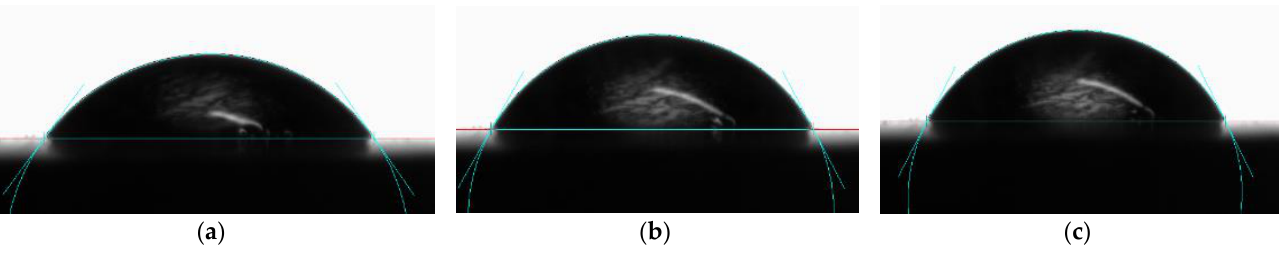
Coatings 2021 , 11 , x FOR PEER REVIEW Figure 6. Surface contact angle Ɵ W as the: ( a ) Sialon and ( b ) Alu C content function in the coatings. Figure 6. Surface contact angle T W as the: ( a ) Sialon and ( b ) Alu C content function in the coatings.